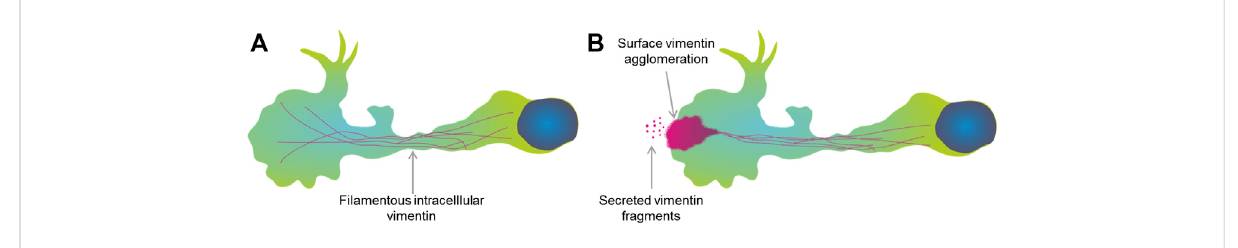
FIGURE 7 Proposed model of vimentin secretion. (A) A macrophage with intracellular vimentin in the fi lamentous form. (B) Dissociation of fi lamentous vimentin at the cell membrane in the activated macrophage might lead to agglomeration at the surface of the macrophage. Then, the vimentin can be released into the extracellular space in the form of small